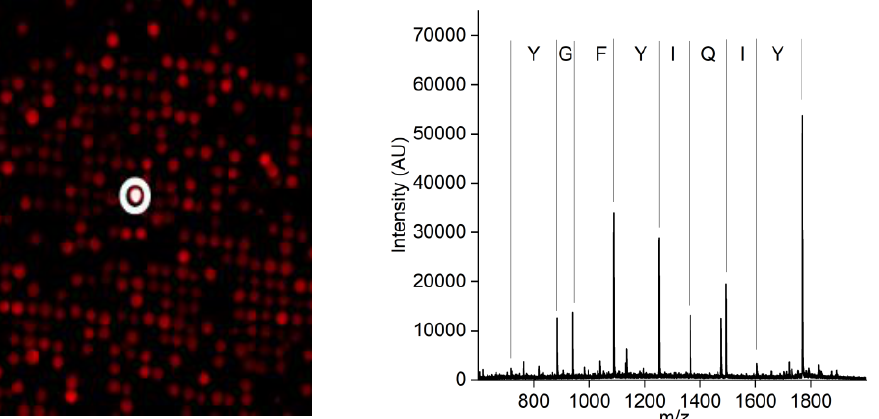
Figure 3. Left : A small image detail of the combinatoric peptide library immobilized on a glass slide after incubation with fluorescently labeled CCMV in a diluted extract of Vigna unguiculata . In total, approximately 25,000 different peptides were screened on one chip. The positive bead is highlighted with a white circle. Right : MALDI-TOF mass spectrum of the peptide after cleavage from the bead. The ladder sequence introduced during peptide synthesis allows for the simple readout of the peptide sequence without the need for fragmentation.